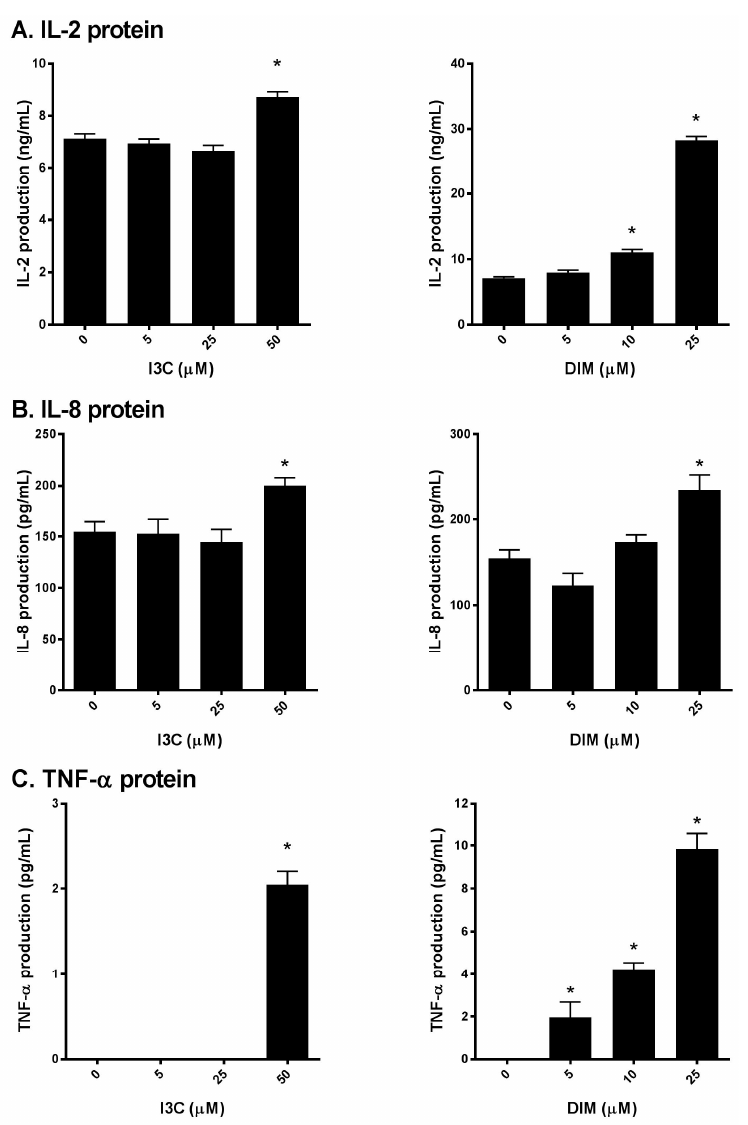
Figure 3. Effects of I3C, DIM on IL-2, IL-8 and TNF- α protein secretion in Jurkat cells. Jurkat cells were treated with 5, 25 or 50 µ M of I3C or 5, 10 or 25 µ M of DIM for 48 h and then stimulated with PMA + ionomycin for 24 h. Media were harvested and: ( A ) IL-2; ( B ) IL-8; and ( C ) TNF- α protein determined using enzyme linked immunosorbent assay (ELISA). Results expressed as mean ± SD ( n = 3) from three independent experiments. * indicates significantly different from control at p < 0.05 (Two-Way Anova).